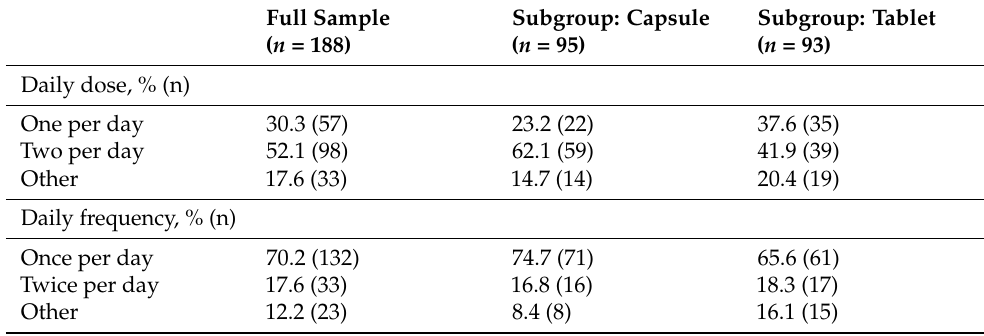
Table 7. Daily Supplement Intake Preferences.